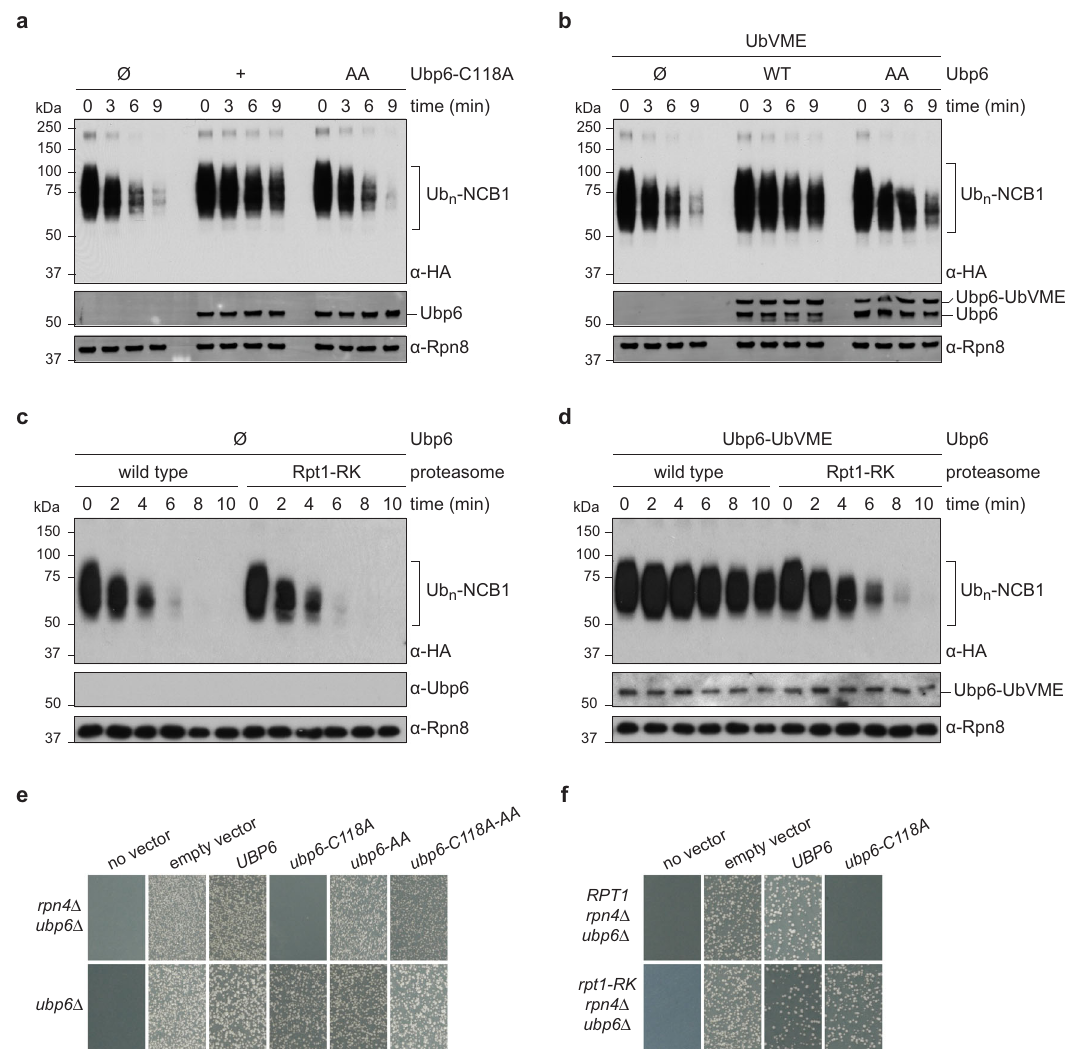
Fig. 4 Ubp6-AA and Rpt1-RK mutants are impaired in the Ubp6 noncatalytic effect. a In vitro degradation assay performed with C118A or the C118A I329A L330A triple mutant of Ubp6, proteasome, and HA-Ub n -NCB1 (detected with anti-HA antibody). Ubp6 and Rpn8 are loading controls. b Inhibition of HA-Ub n -NCB1 degradation by Ubp6-UbVME. UbVME was preincubated with Ubp6 variants to covalently modify C118, abolishing deubiquitinating